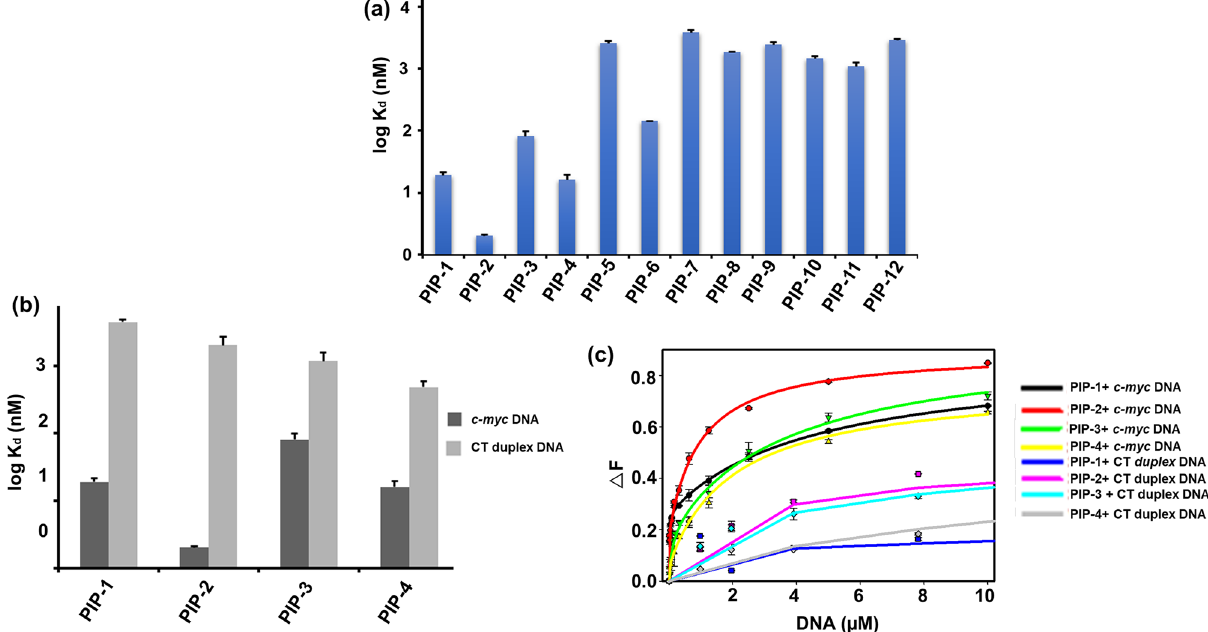
Figure 3. Screening of Piperine analogs with c-myc G4 DNA via steady-state fluorescence titration study. ( a ) The bar diagram represents the binding constant values of Piperine analogs (2 nM) with c-myc G4 DNA. ( b ) The comparative bar diagram depicts the K d values of lead Piperine analogs with c-myc G4 and CT duplex DNA (Control). ( c ) A combined binding plot showed the change in the fluorescence intensity upon binding Piperine analogs with c-myc G4 DNA and CT duplex